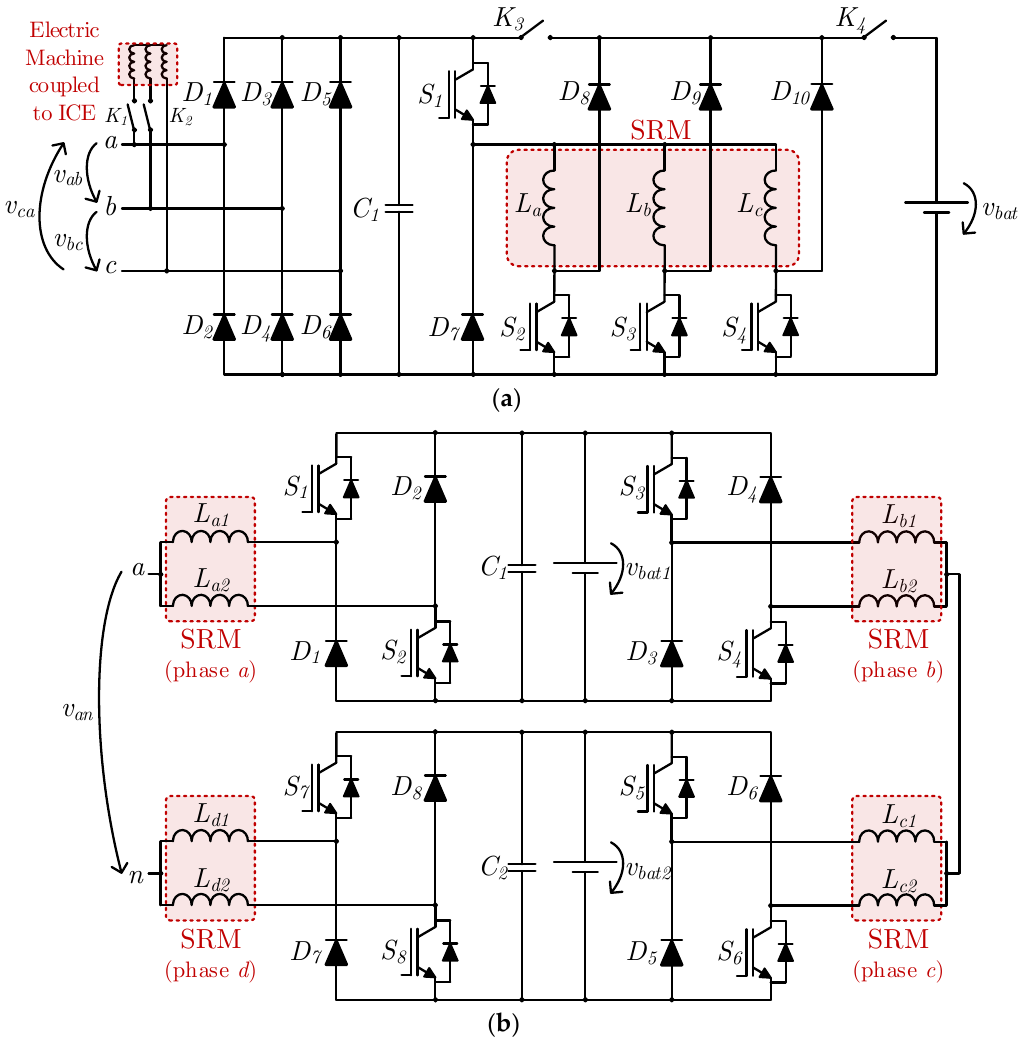
Figure 8. EV IBCs based on SRMs proposed by Y. Hu et al. in: ( a ) 2014 [21]; ( b ) 2015 [22].